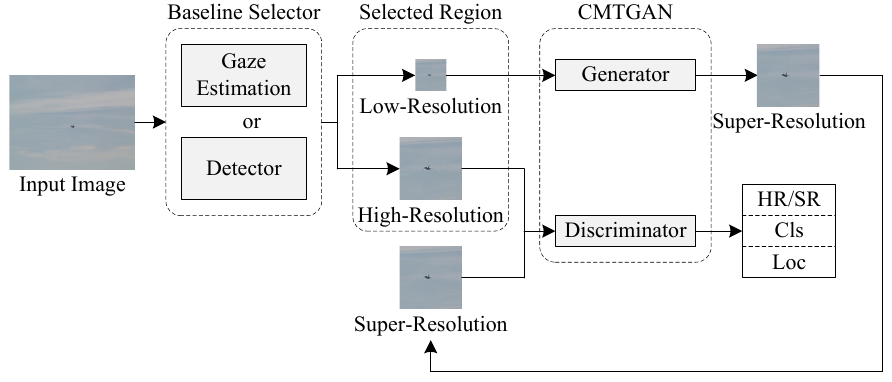
Figure 1. Workflow of CMTGAN.